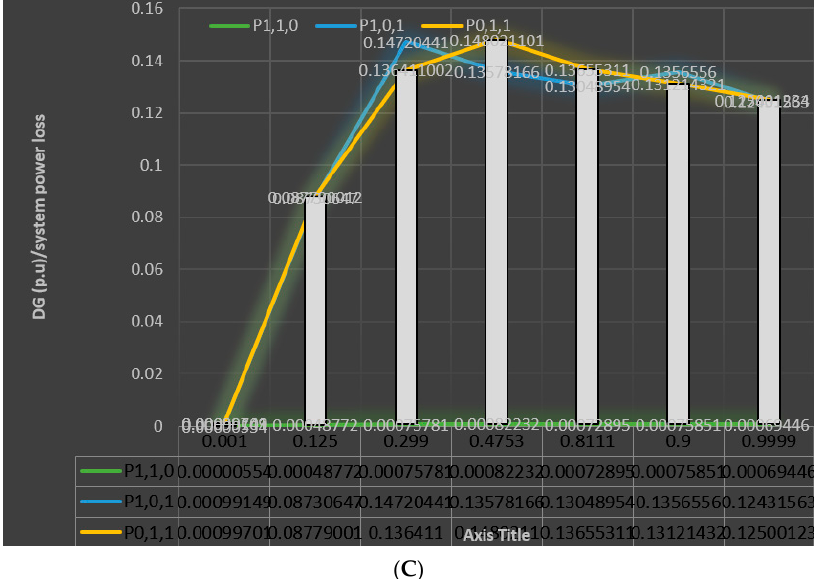
Figure 5. ( A ) Result of objective function in terms of power loss reduction with installation of DG system. ( B ) Result of voltage profile improvement with installation of DG System. ( C ) DG size, bus location and system power loss of 33-bus test system. The base case voltages for the allocation values in each bus are presented in Figure 6, the values of the voltages in (per units) are represented in the vertical axis, while the bus numbers are represented in horizontal axis. It can be observed from Figure 6.placement of hybrid renewable system based on the proposed methodology significantly reduces loses, which is expected as part of the technical objectives.